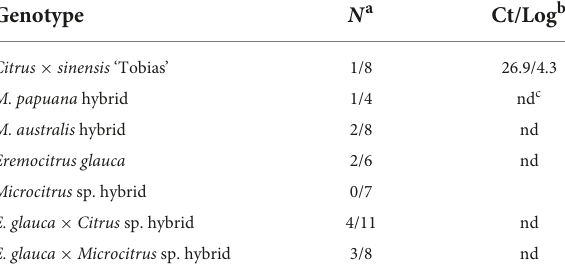
TABLE 5 Graft success and titer of ‘ Candidatus Liberibacter asiaticus’ (Las) in new shoots grown from budwood of ‘Valencia’ sweet orange top-grafted on Oceanian citrus genotypes and ‘Tobias’ sweet orange, all growing onto Las-infected ‘Rangpur’ lime rootstocks, as determined through detection of Las16S DNA by qPCR 60 days after bud